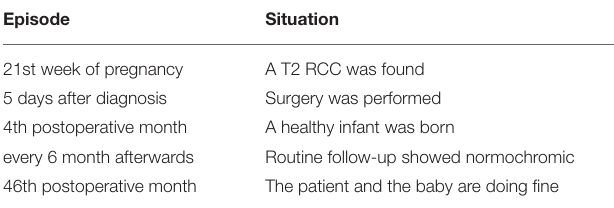
TABLE 1 | Timeline of the whole treatment